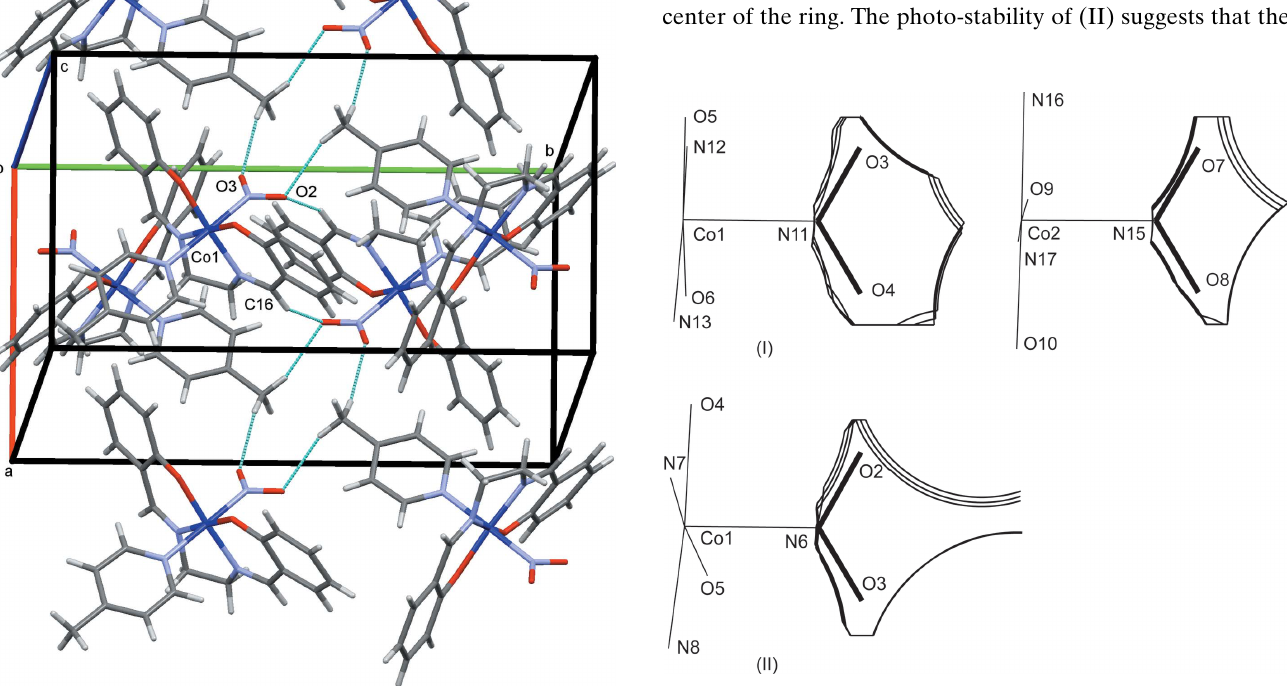
Figure 5 Comparison of the slices of the cavity around the nitro group within 0.1 A˚ from the plane in (I) and